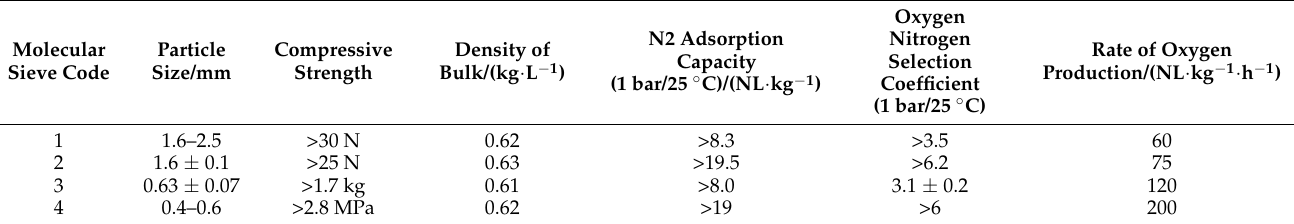
Table 2. Comparison of several commonly used molecular